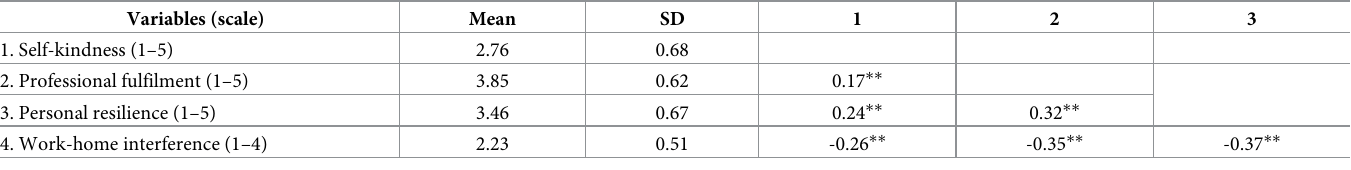
Table 2. Means, standard deviations and pearson correlations for self-kindness, professional fulfillment, personal resilience and work-home interference. Variables (scale)